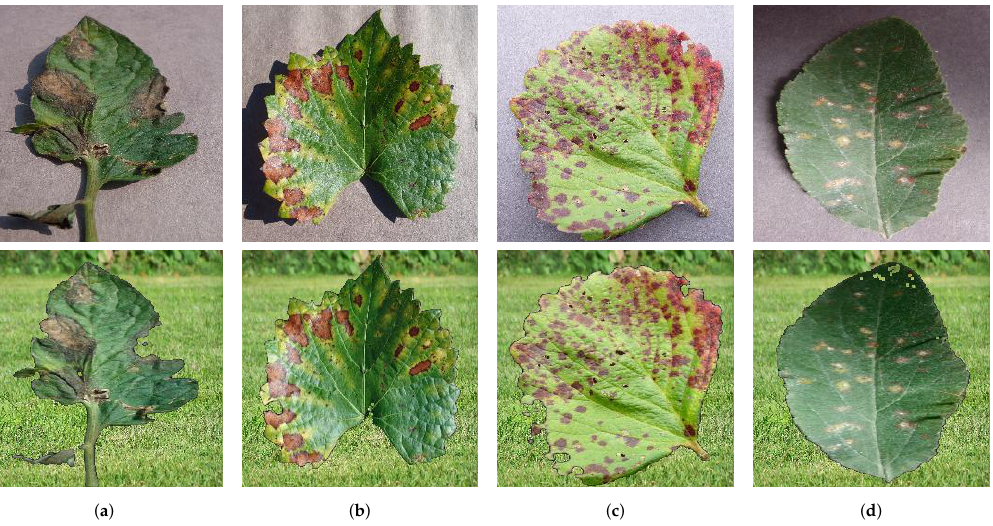
Figure 4. Example of images included in the PlantVillage dataset [38] from different plant diseases along with their equivalent in the Synthetic PlantVillage dataset. ( a ) Tomato—blight; ( b ) grape—esca; ( c ) strawberry—scorch; ( d )